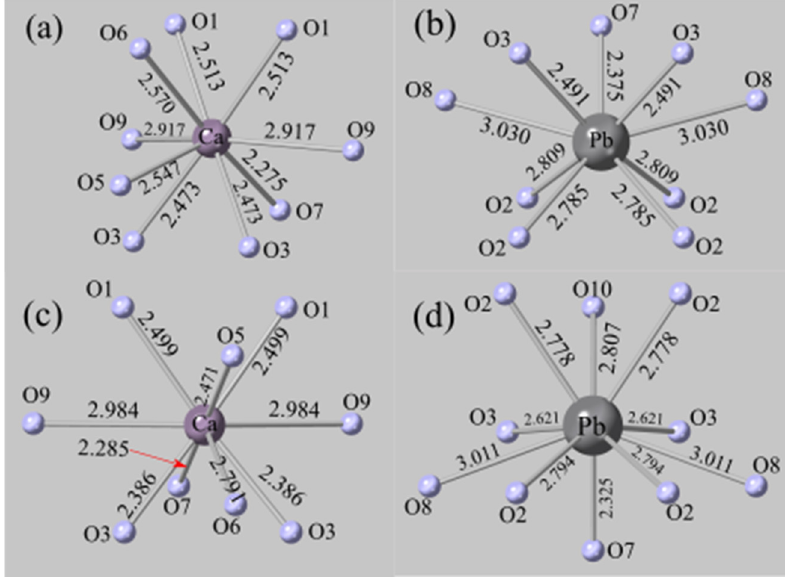
Figure 7. Comparison of the geometry of the Ca and Pb coordination polyhedra of zoisite-(Pb) ( a , b ) and of hancockite ( c , d ). The asymmetrical distribution of bond lengths in zoisite-(Pb) Pb polyhedron (Figure 7b), with Pb cation distinctly displaced towards O3-O7-O3 polyhedral face, can be attributed to the presence of an active lone pair effect of Pb cation. Pb polyhedron in hancockite (Figure 7d) lacks instead such a lopsided distribution of anions.